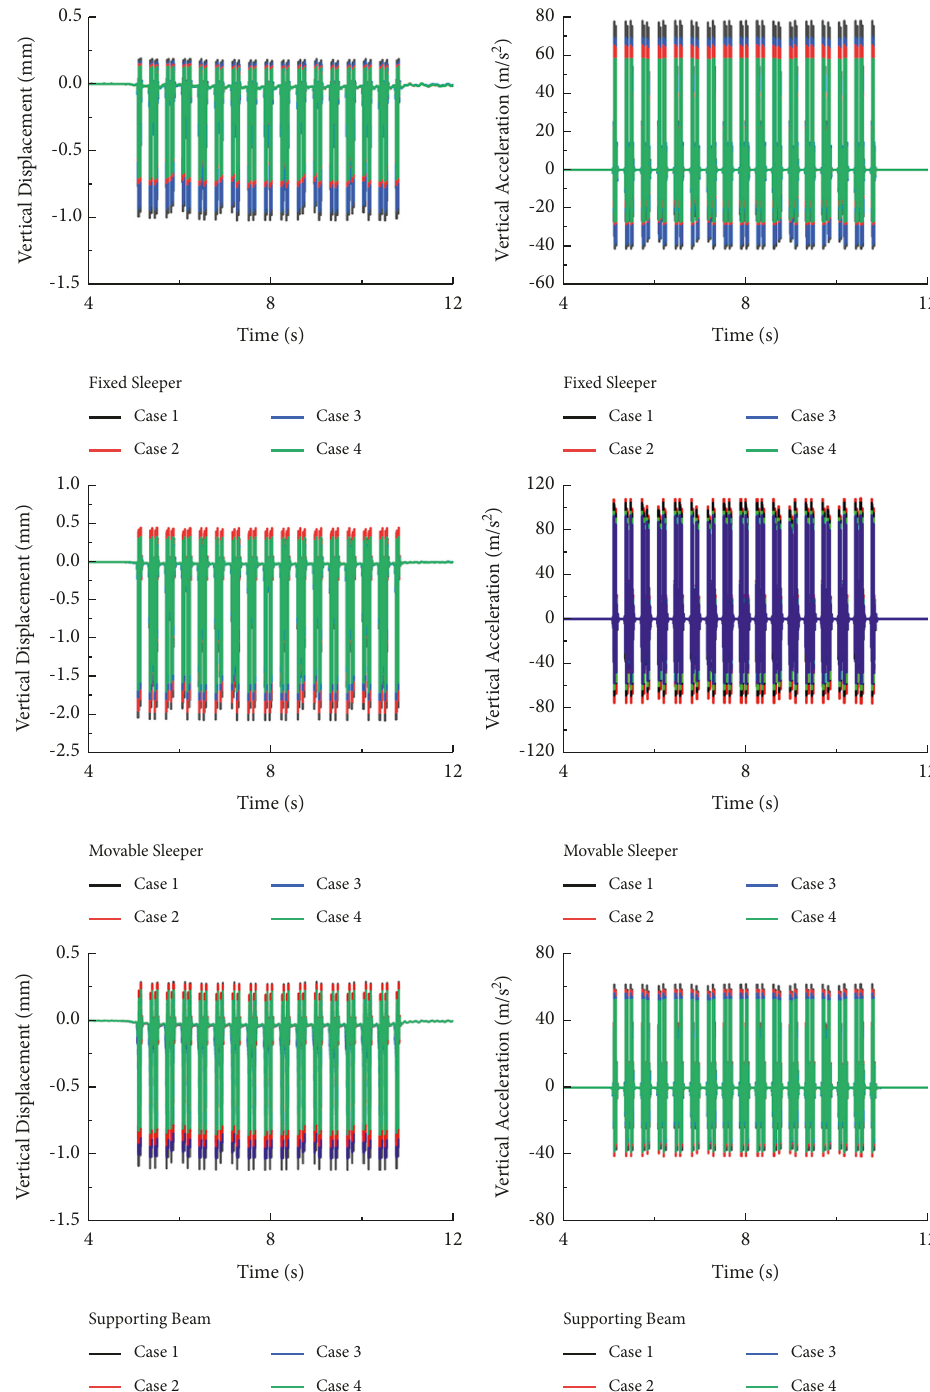
Figure 13: Time histories of the dynamic response of BEJs in different